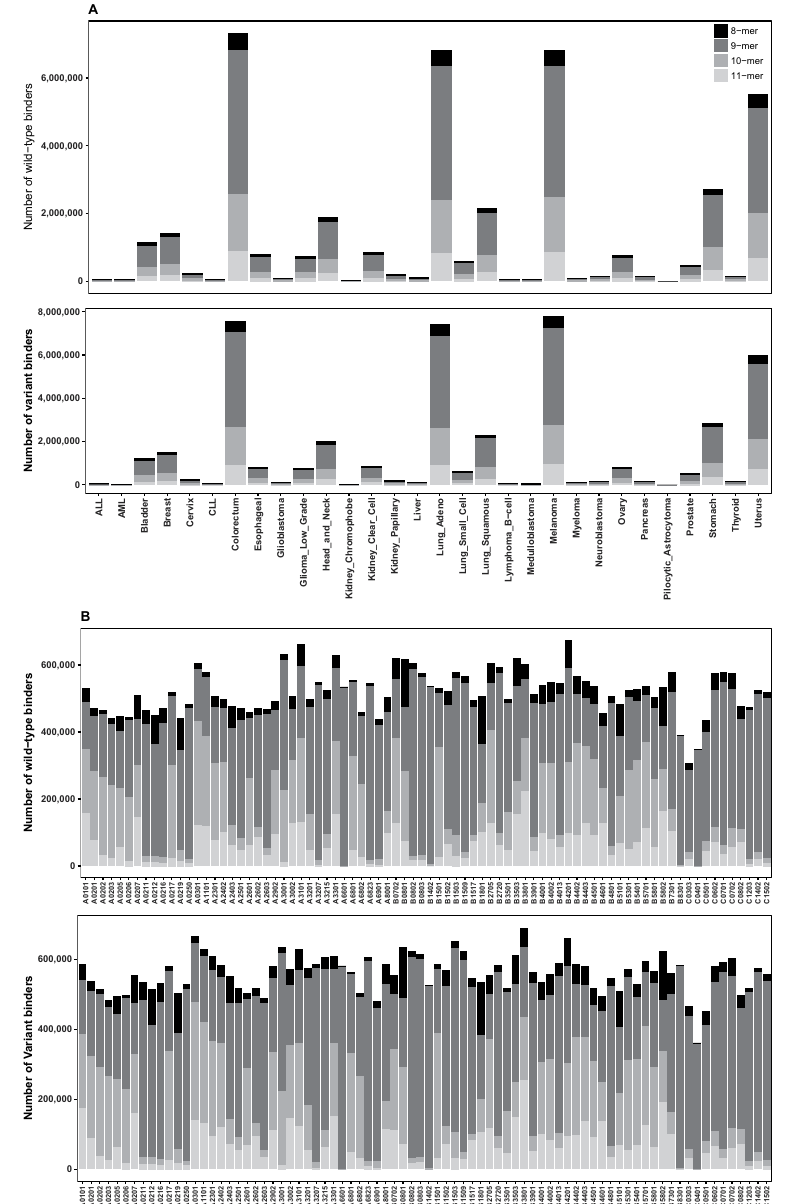
Figure 2. The distribution of peptide binders across cancer types and HLAs. ( A ) Distribution of predicted peptide binders across cancer types. The numbers of binding peptides are very similar for the wild-type and the variant datasets. The proportion of binders follows the overall rate of variations in the cancer types. ( B ) Distribution of predicted peptide binders across HLAs. The binders were distributed evenly across the